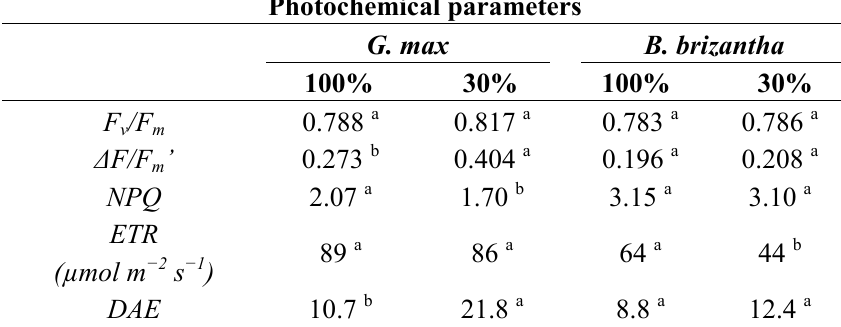
Table 5. Mean values of the potential ( F quantum efficiency, the photochemical ( qP ) and the non-photochemical ( NPQ ) extinction coefficient, and the apparent electron transport rate ( ETR ) in G. max and B. brizantha under different water regimes (100% and 30% refill of the total amount of the evapontranspired water).